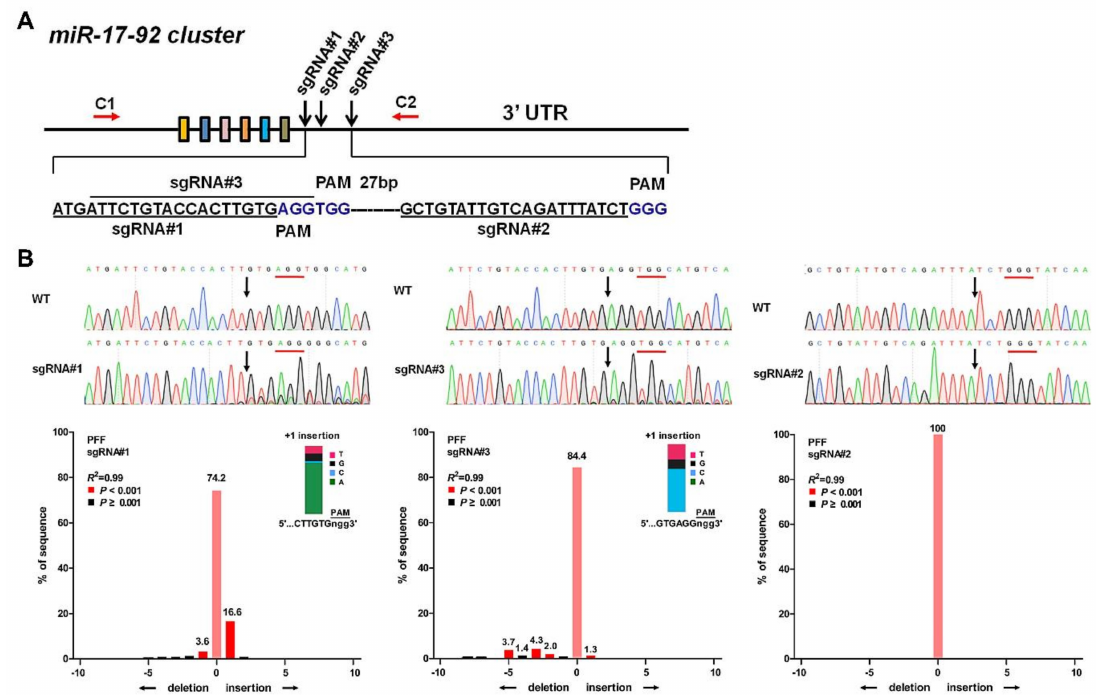
Figure 2. TIDE analysis of p miR-17-92 targeted with designed sgRNAs in PFFs. ( A ) Schematic representation of sgRNAs specific to the 3 (cid:48) UTR of p miR-17-92 . The sgRNA sequence is highlighted in black, and PAM is highlighted in blue. ( B ) A pool of PFF cells treated with Cas9 alone (control) and cells treated with Cas9 and a p miR-17-92 -targeting sgRNA (sgRNA#1, sgRNA#2 or sgRNA#3) (sample) were analyzed by TIDE. Insets: Prediction of the inserted base for +1 insertions. PAMs are underlined in red and the cleavage sites are labelled with black